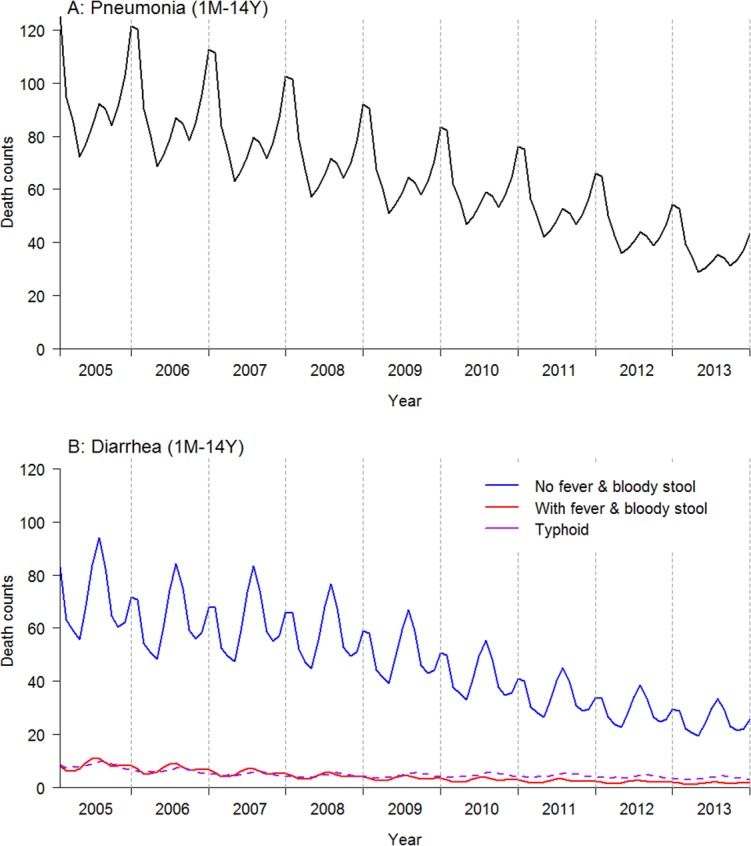
Time series model by pneumonia and diarrhea total.Diarrhea deaths are split into subsets of cases with/without both fever and bloody stool, as well as typhoid and paratyphoid fever deaths. Pneumonia deaths are defined by ICD-10 codes A37, H65-H68, H70, H71, J00-J22, J32, J36, J85, J86, P23, or U04. Diarrhea deaths were defined by ICD-10 codes A00, A02-A09, and distinguished further based on symptoms reported in the verbal autopsy. Typhoid and paratyphoid fever deaths were defined by ICD-10 code A01. Each dashed vertical line designates December of each year. Data was modeled using a generalized additive model and Poisson regression, using monthly count of deaths from the Million Death Study. Each vertical dashed line designates December of each year.10.7554/eLife.46202.009Figure 3—figure supplement 1—source data 1.Predicted values for pneumonia (total), diarrhea (by symptom profile; with fever and bloody stool, without fever and bloody stool), and typhoid/paratyphoid fever (total) mortality time series models; 2005-2013.